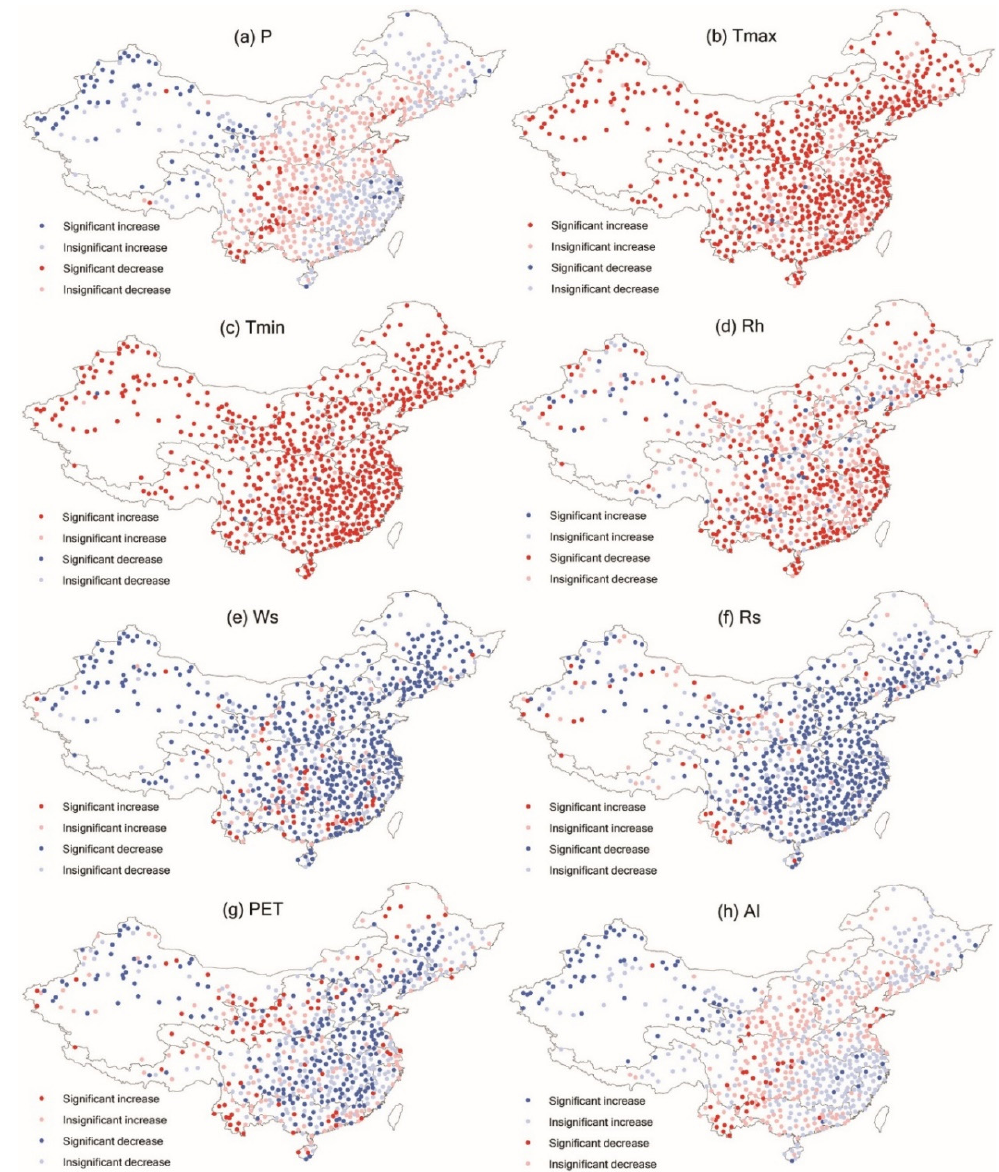
Figure 2. Trends of annual precipitation (P), maximum temperature (Tmax), minimum temperature (Tmin), relative humidity (Rh), wind speed (Ws), radiation (Rs), potential evapotranspiration (PET), and aridity index (AI) from 1961 to 2016 across the 713 climate stations. The trends were detected using the Mann–Kendall test at the significance level of 5%. The changes in climatic variables that drive AI to increase (i.e., increasing P and Rh; decreasing Tmax, Tmin, Ws, Rs, and PET) and decrease (i.e., decreasing P and Rh; increasing Tmax, Tmin, Ws, Rs, and PET) are denoted by blue and red dots, respectively.